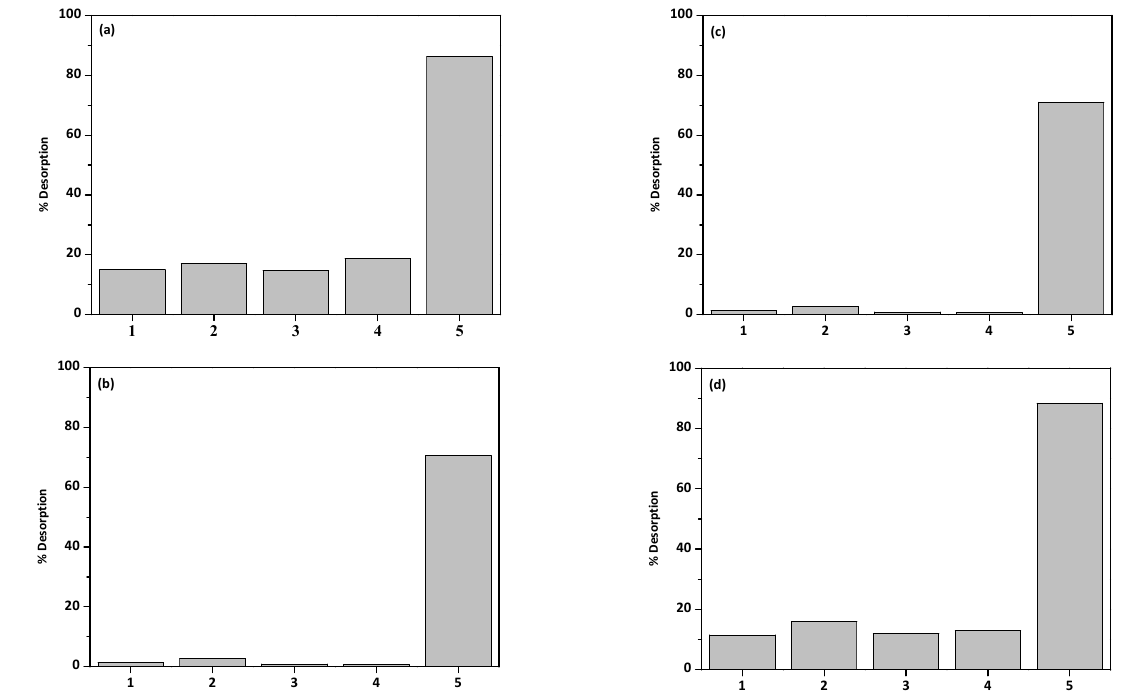
Figure 11. The desorption process of ( a ) Cu(II), ( b ) phenol from NaP1, ( c ) Cu(II), ( d ) phenol from NaP1CS with different desorption solutions 1: 0.5 M NaCl, 2: 0.5 M NaOH, 3: 0.5 M KCl, 4: 30% CH 3 OH, and 5: 0.5 M HCl.